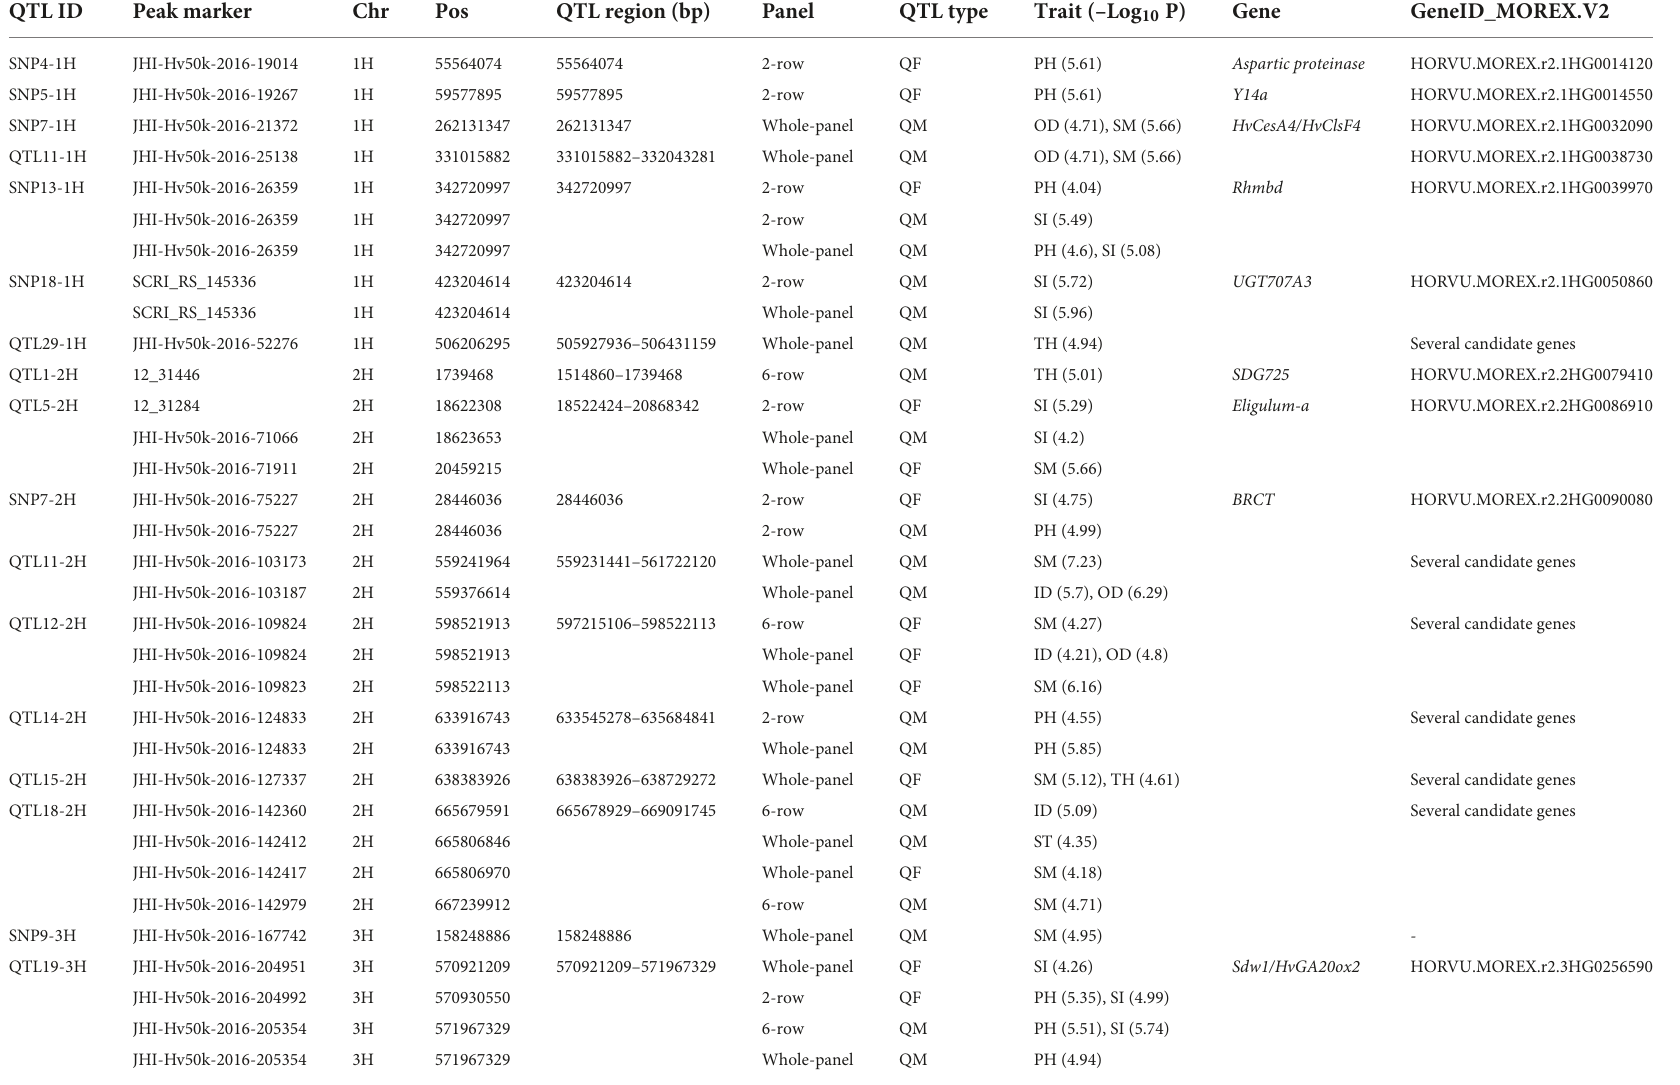
TABLE 2 Summary of candidate genes underlying the most significant markers with QM and QF effect on studied traits using multi-environment